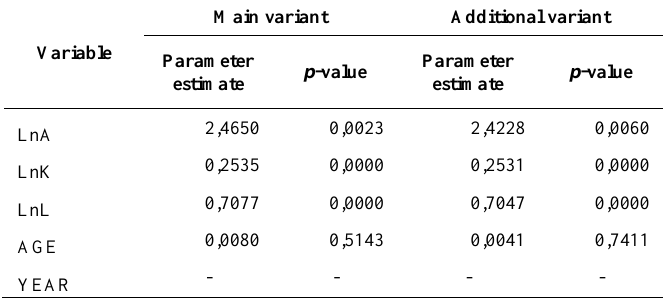
Table 4. Production function estimates of productivity